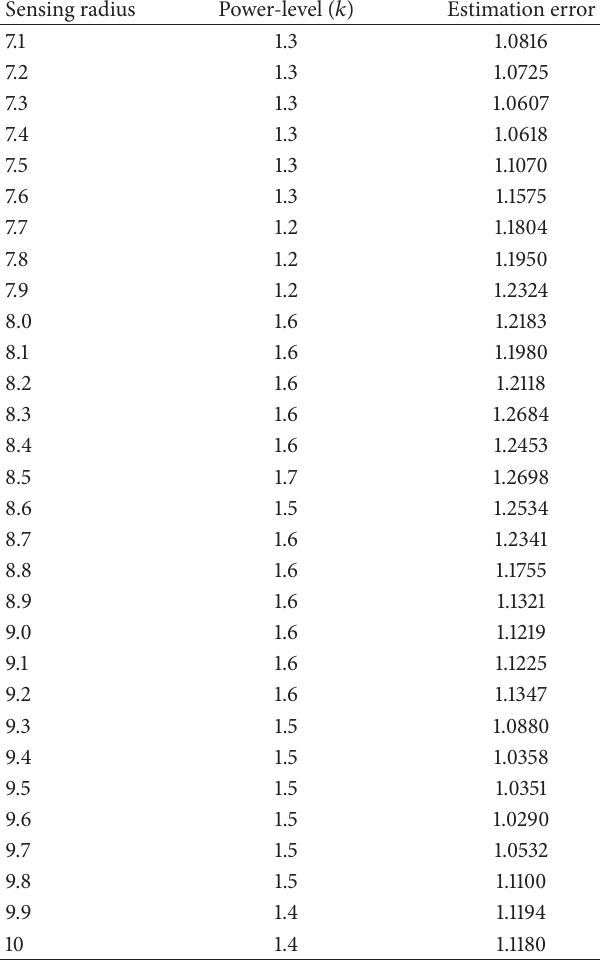
Table 2: The estimation errors with corresponding variables for Path 2 movement.